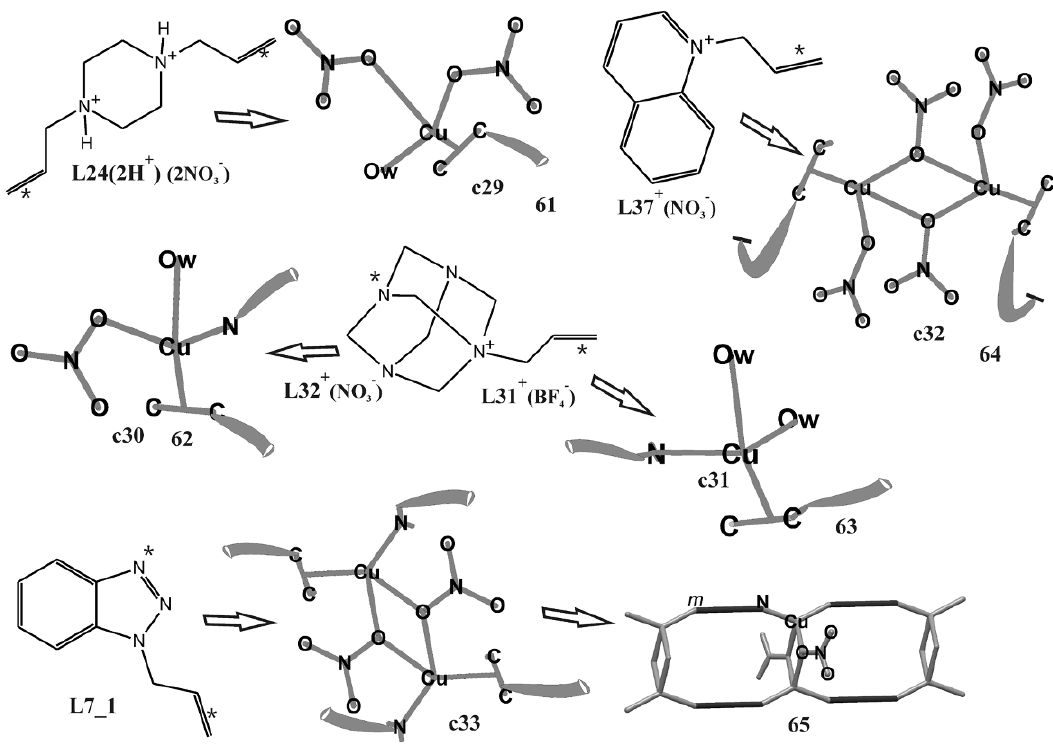
Figure 14. Structural genesis of C29-C33 fragments in 61-65